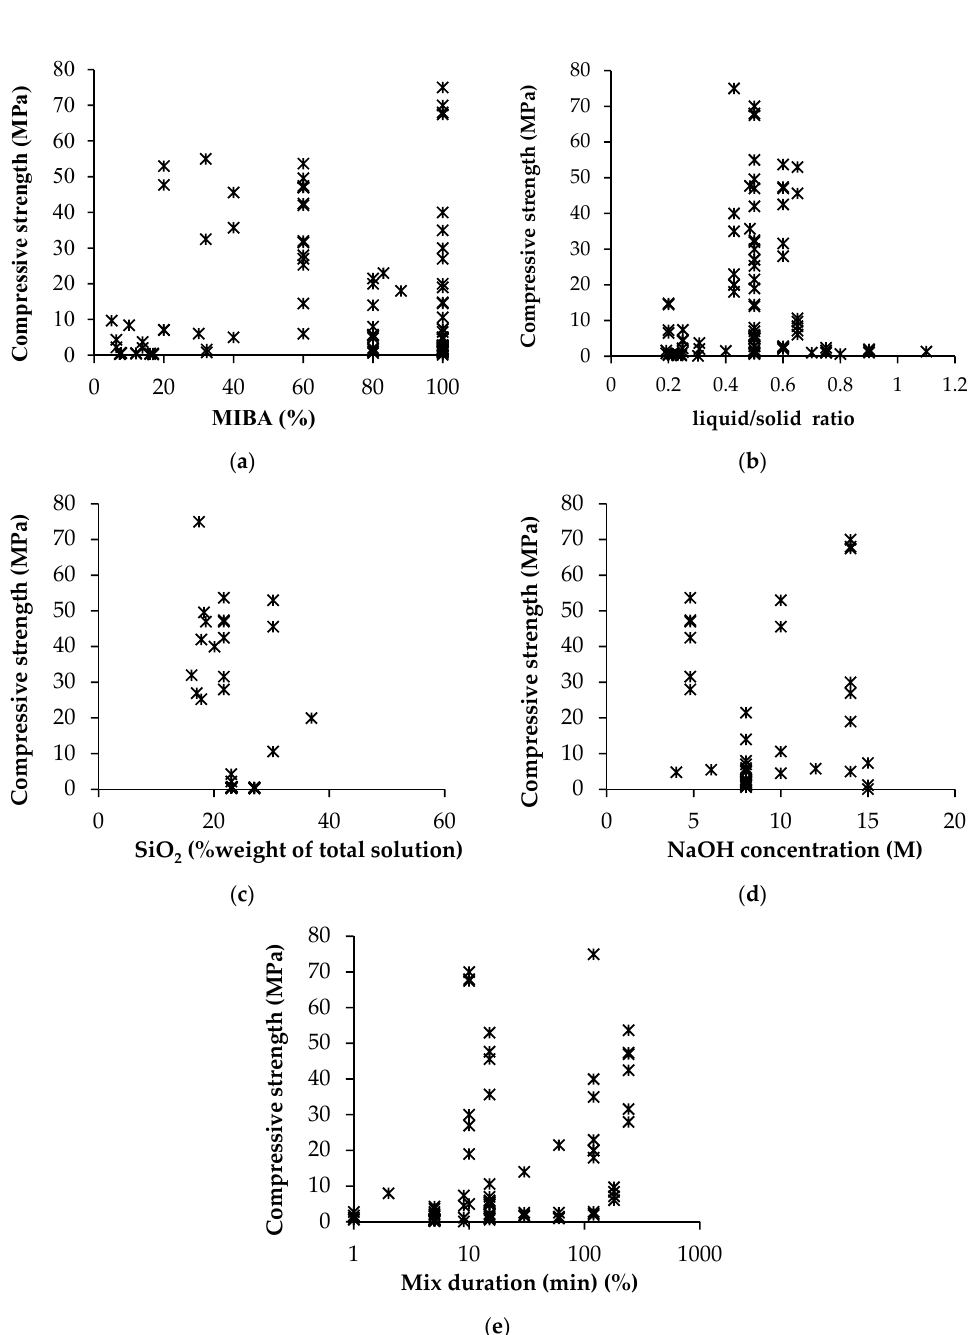
Figure 5. Compressive strength vs. ( a ) MIBA incorporation ratio, ( b ) liquid/solid ratio, ( c ) total SiO 2 quantity in solution, ( d ) NaOH concentration and ( e ) mix duration.